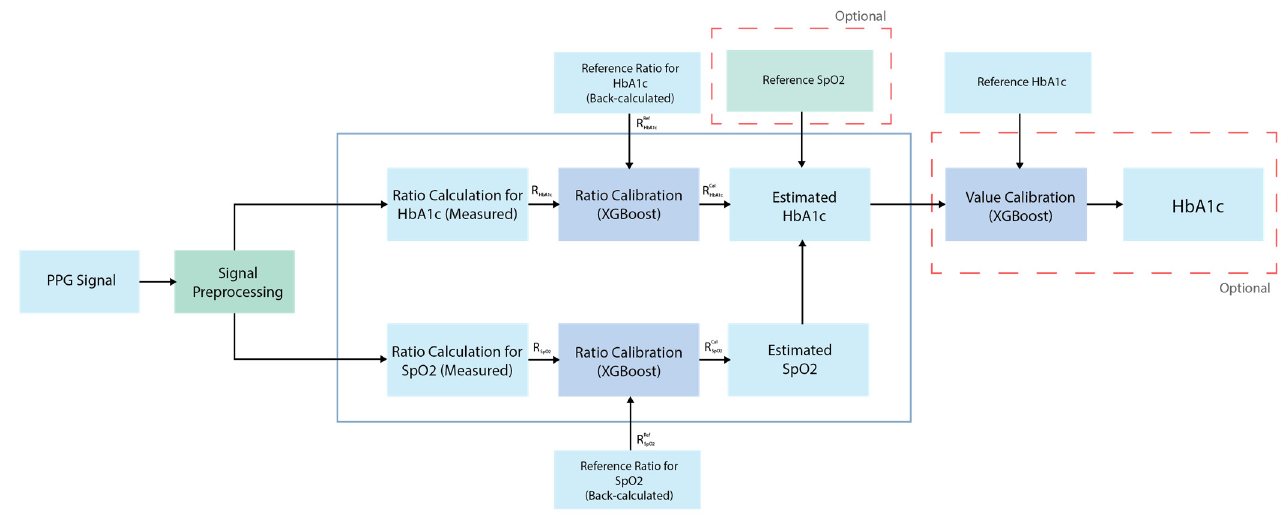
Figure 3. HbA1c estimation using only two